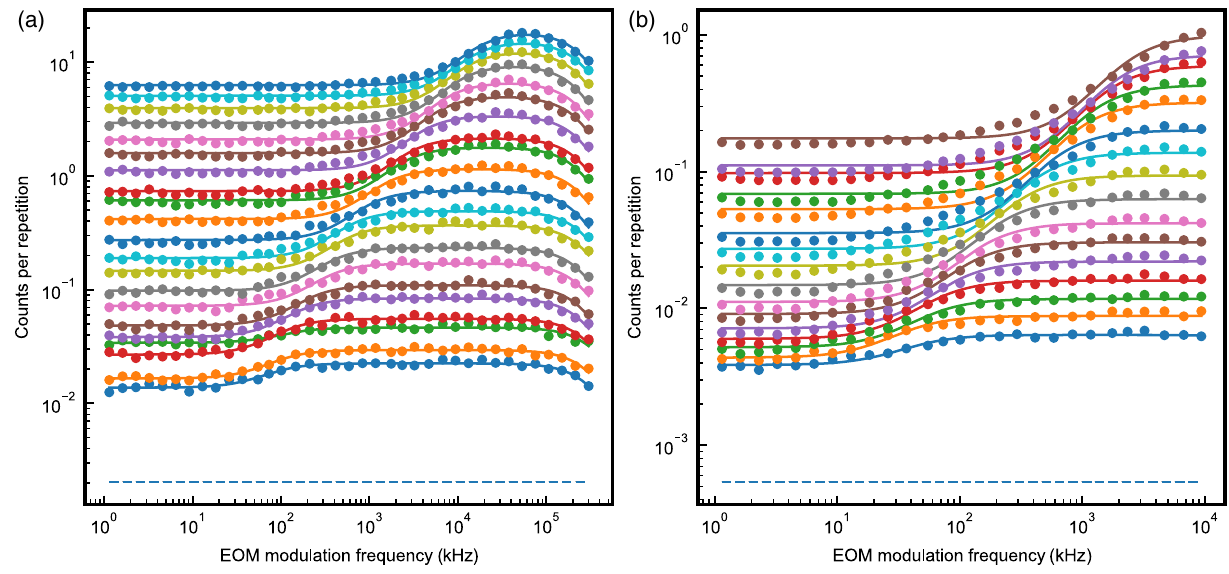
FIG. 16. Measurement of the homogeneous linewidth using one EOM (a) or three concatenated EOMs (b) to generate 3 or 27 lines. The different randomly chosen colors indicate measurements at different power. At the same power-broadened homogeneous linewidth, a better signal-to-noise ratio is obtained when using three EOMs instead of only